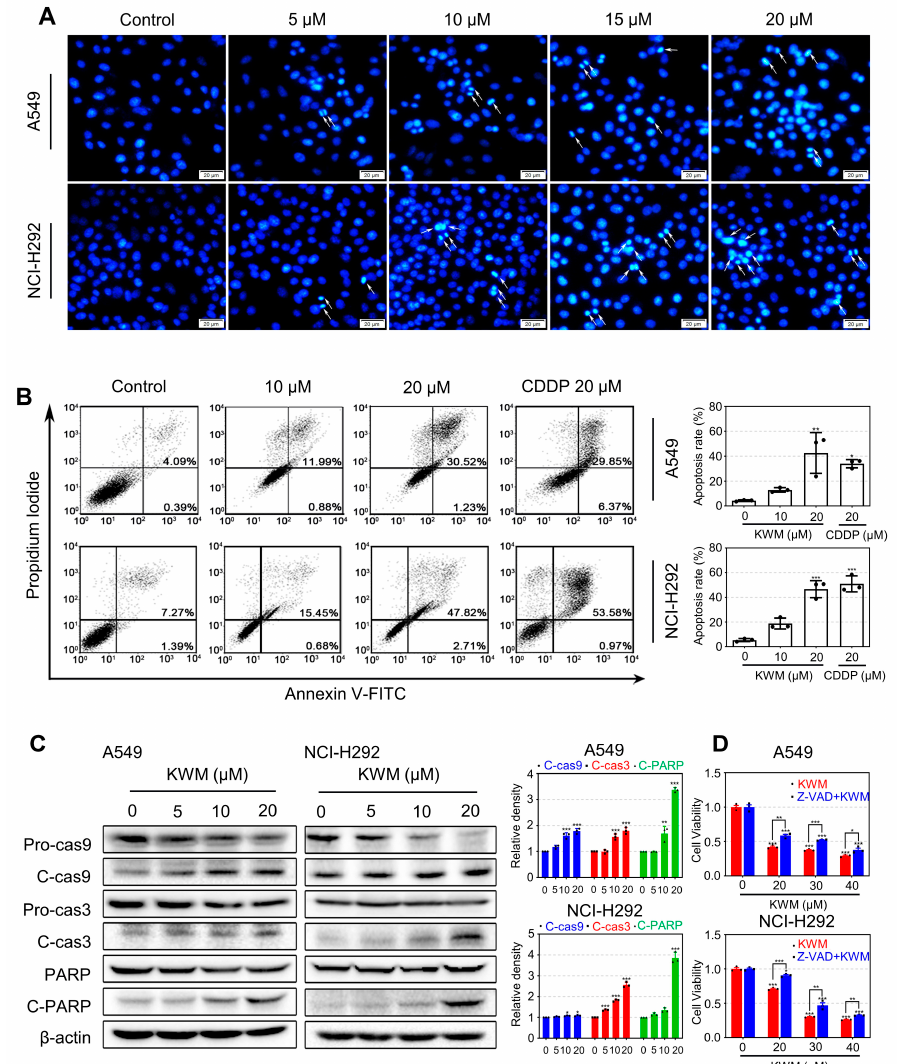
Figure 2. KWM-induced apoptosis in A549 and NCI-H292 cells. ( A ) Cells were incubated with different concentrations of KWM for 24 h, and the changes in nuclear morphology were recorded by fluorescence microscopy after DAPI staining. ( B ) Cells were treated with KWM for 48 h, stained with Annexin V/PI and a flow cytometry assay was performed. CDDP treatment was used as positive control. ( C ) Cells were treated with KWM as indicated doses for 24 h, and cell lysates were subjected to immunoblotting for caspase-3, caspase-9 and PARP. The β -actin was used as the loading control. ( D ) A549 and NCI-H292 cells were pretreated for 2 h with Z-VAD-FMK (20 μ M) prior to addition of KWM or DMSO. Cell viability was detected by MTT assay after 48 h. The results were mean ± SD from three independent experiments. * p < 0.05, ** p < 0.01, and *** p < 0.001 versus